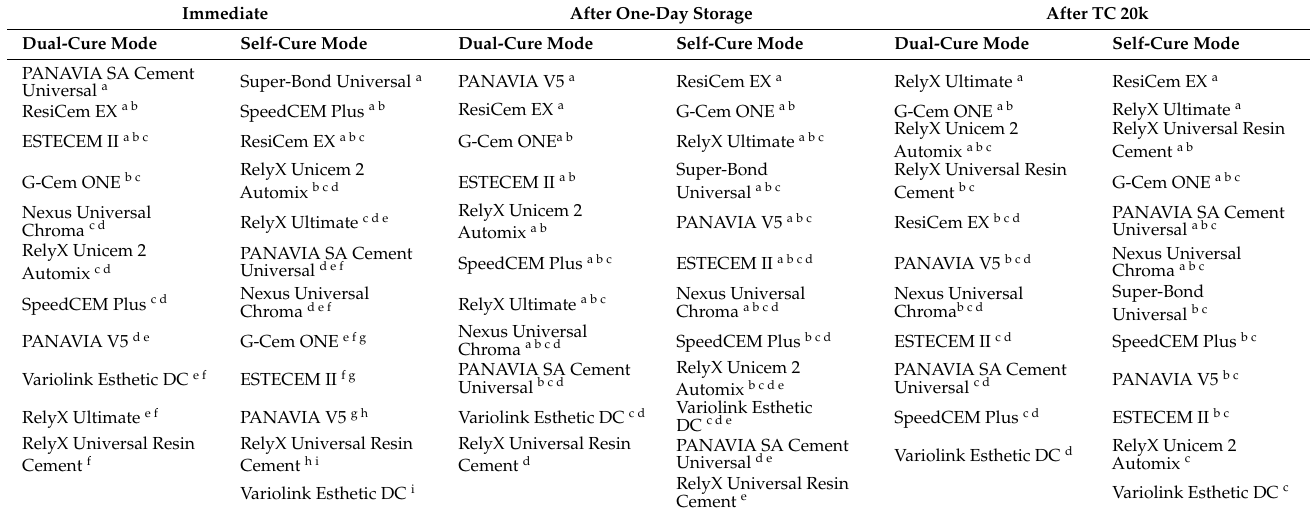
Table 5. Comparison of means (Tukey HSD procedure) for shear bond strength of adhesive resin cement material * at each time period [superscript letters (a–i) represent groups with no significant difference, p > 0.05].